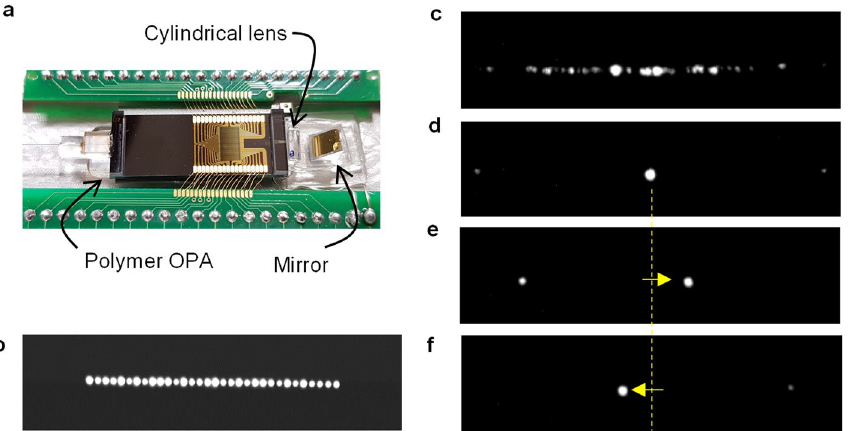
Figure 3. Polymer waveguide OPA characterization. ( a ) Polymer waveguide chip attached on a TEC package along with the fiber pigtail on the input, cylindrical lens for vertical collimation, and 45° mirror. ( b ) Near-field pattern of the output modes of the polymer waveguide array. ( c ) Far-field pattern scattered in the horizontal direction caused by the initial random phases. ( d ) After performing the beamforming procedure, a well-focused main beam was produced, as well as weak side lobes. ( e , f ) Beam scanning in the left and right directions obtained by applying a phase slope signal in addition to the beamforming